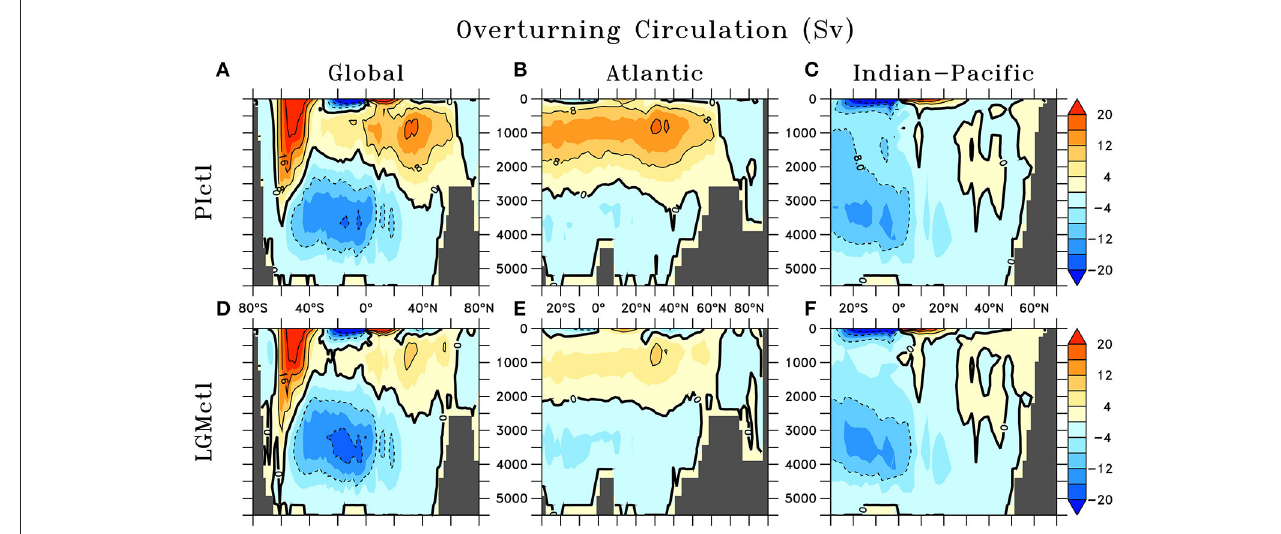
FIGURE 1 | Meridional streamfunction in preindustrial control (PIctl; A–C) and Last Glacial Maximum control (LGMctl; D–F ) in the Global, Atlantic, and Indian-Pacific Oceans,